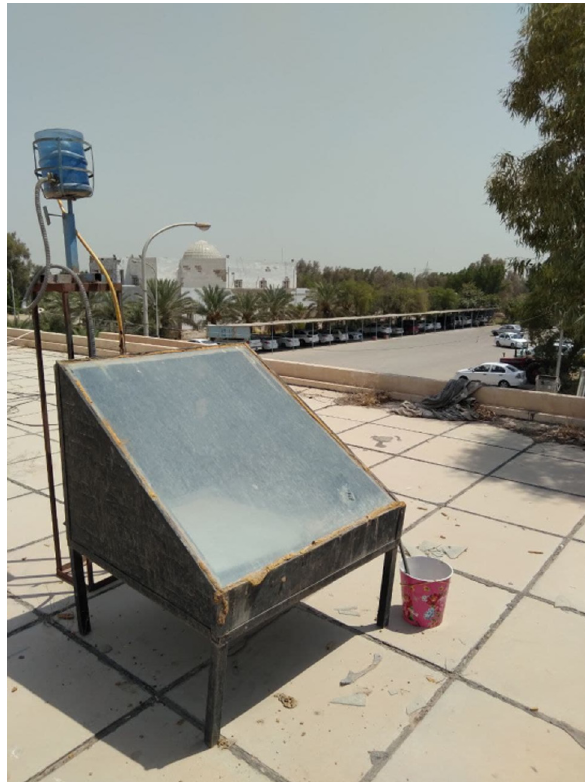
Figure 1: photograph of the CS.